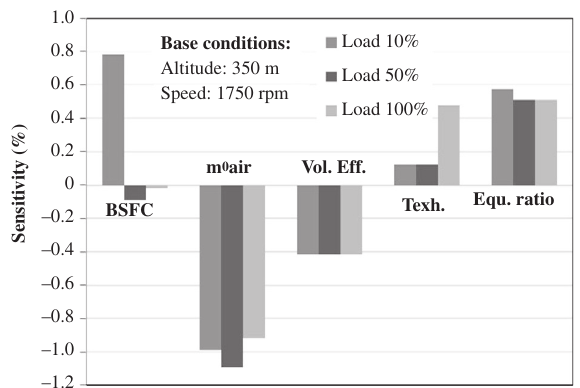
Fig. 9. Results of sensitivity analysis: speed (cid:4) 1750 rpm for the increase of 35 m of the altitude